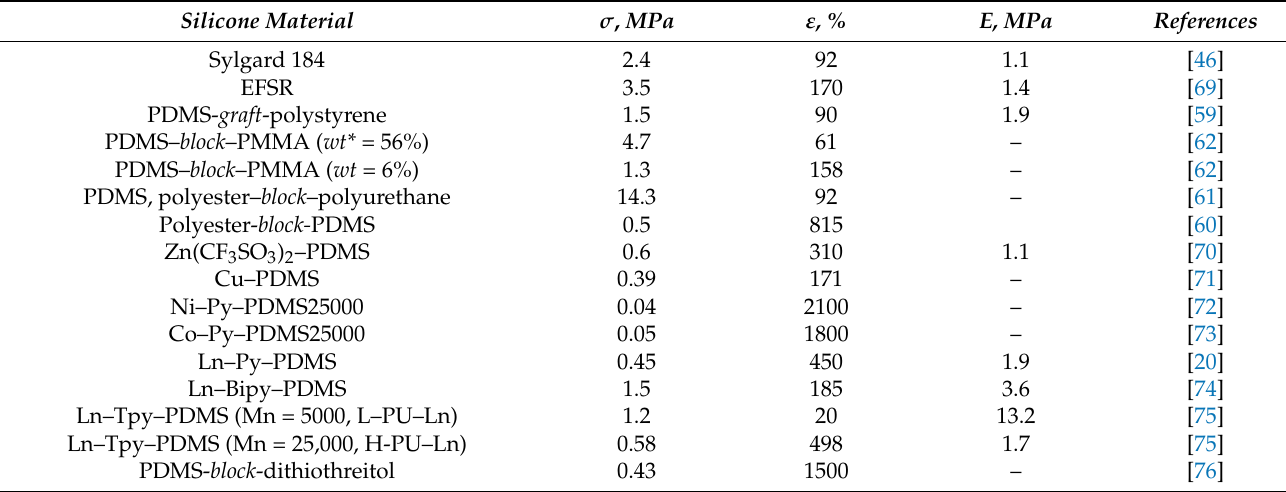
Table 1. Tensile properties of silicone materials used in